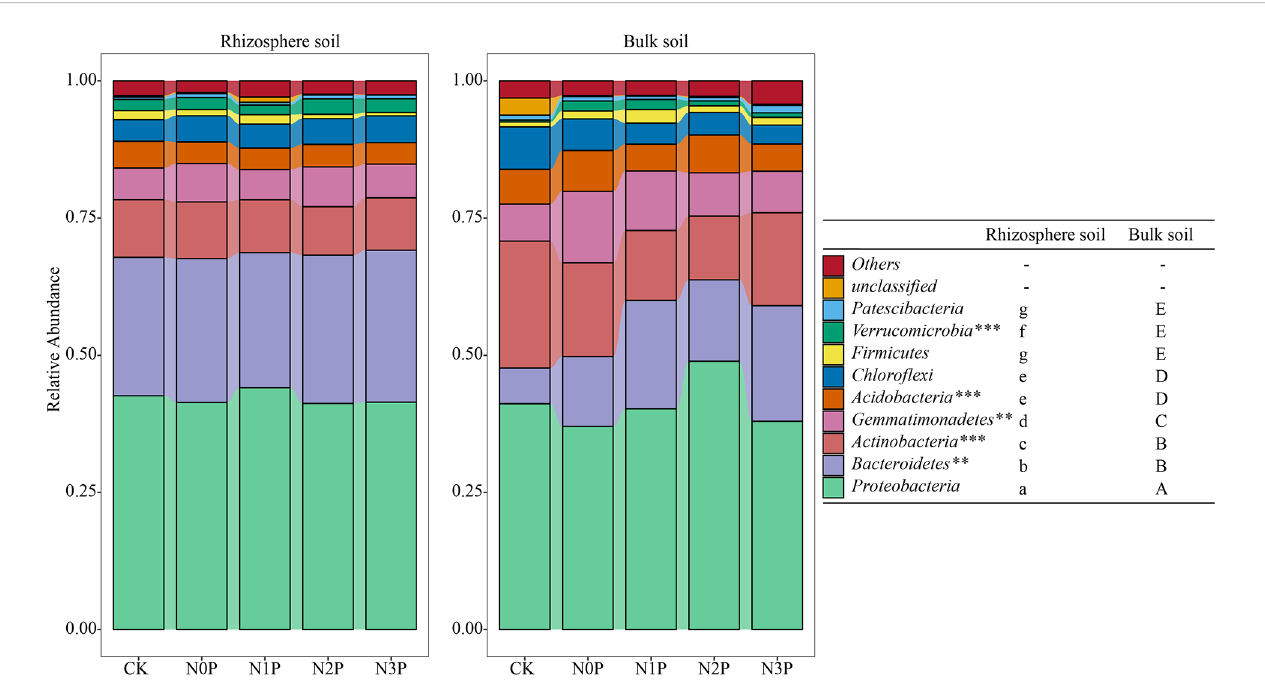
FIGURE 2 The relative abundance of the top 10 bacterial phyla in the rhizosphere and bulk soil of S. salsa at different N-P addition ratio treatments. Different capital letters indicate that the difference between bulk soil bacterial phyla is signi fi cant (P<0.05) and different lowercase letters indicate that the difference between rhizosphere soil bacterial phyla is signi fi cant (P<0.05) as well as **, *** indicate that the difference between different soils is signi fi cant at 0.01 and 0.001 level,